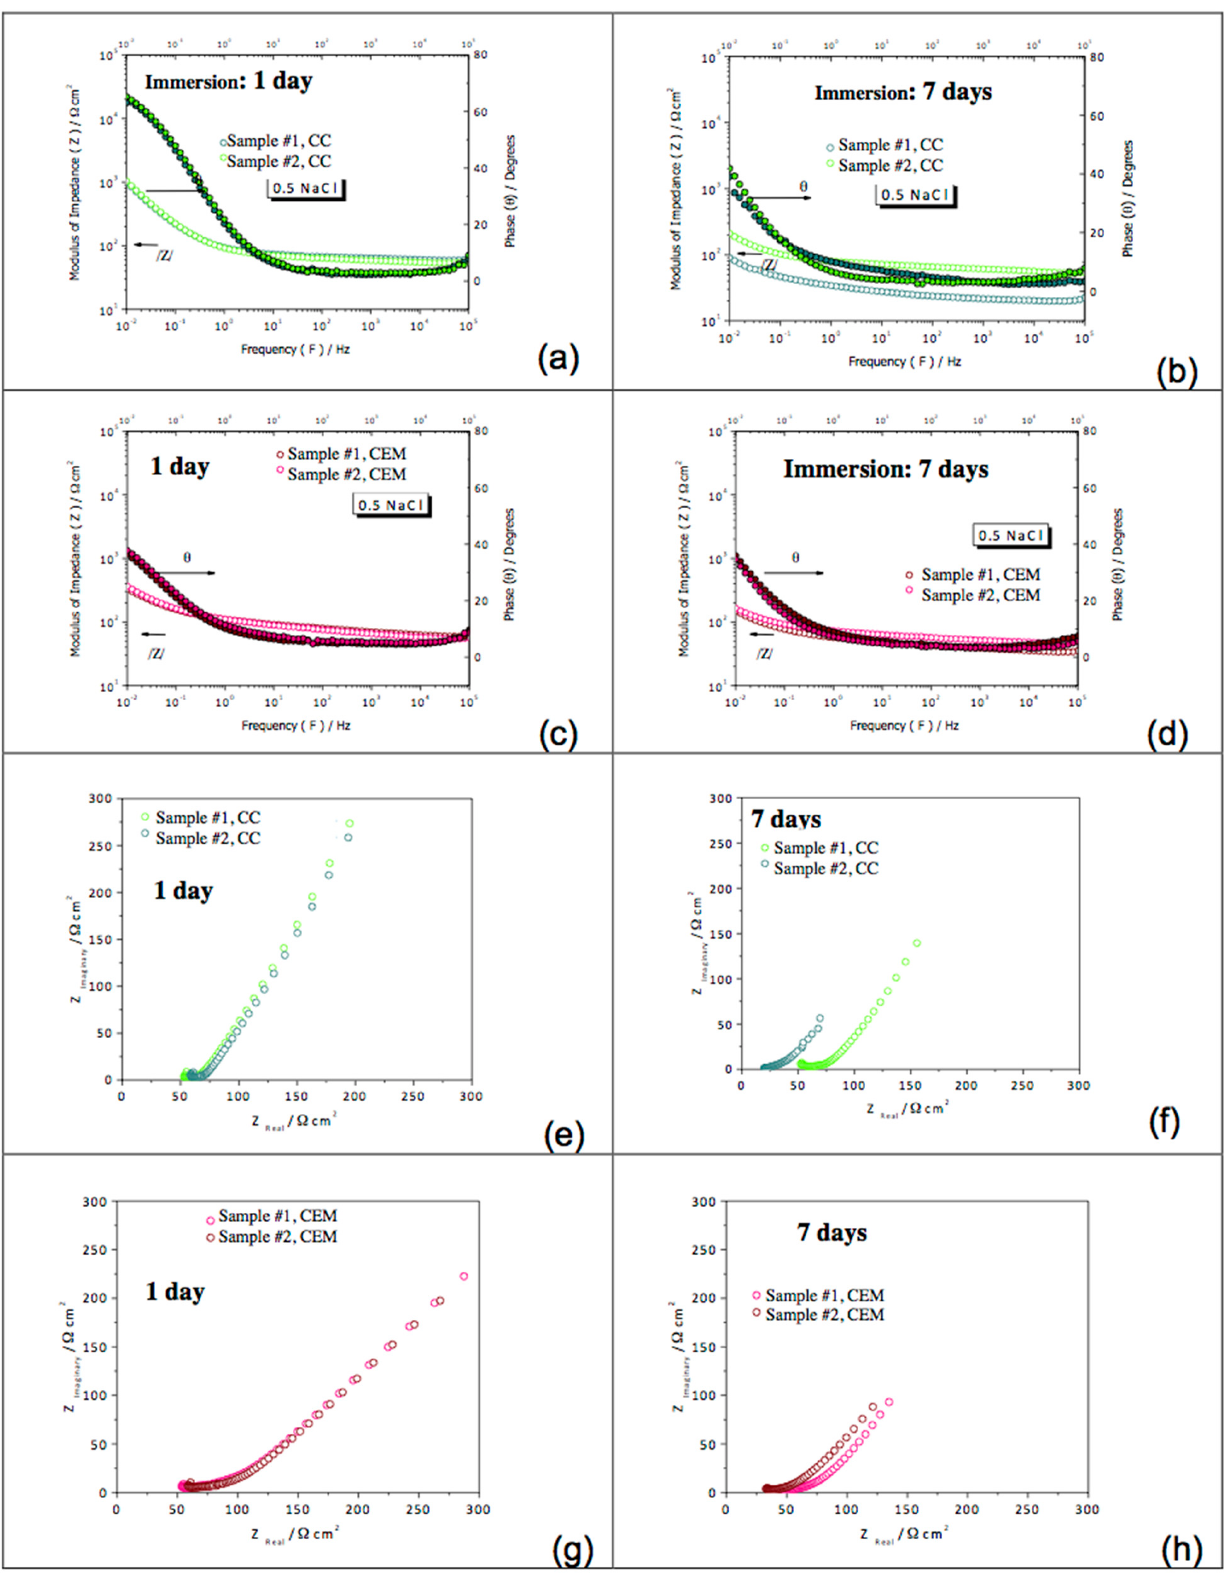
Figure 5. Duplicate of the results for the CC and CEM for 1 and 7 days in Bode/bode-phase ( a ) and ( b ), ( c ) and ( d ); respectively; and Nyquist plots in same periods for the CC and CEM samples for 1 day ( e ) and ( g ); and during 7 days during 1 and 7 days; ( f ) and ( h ), respectively.